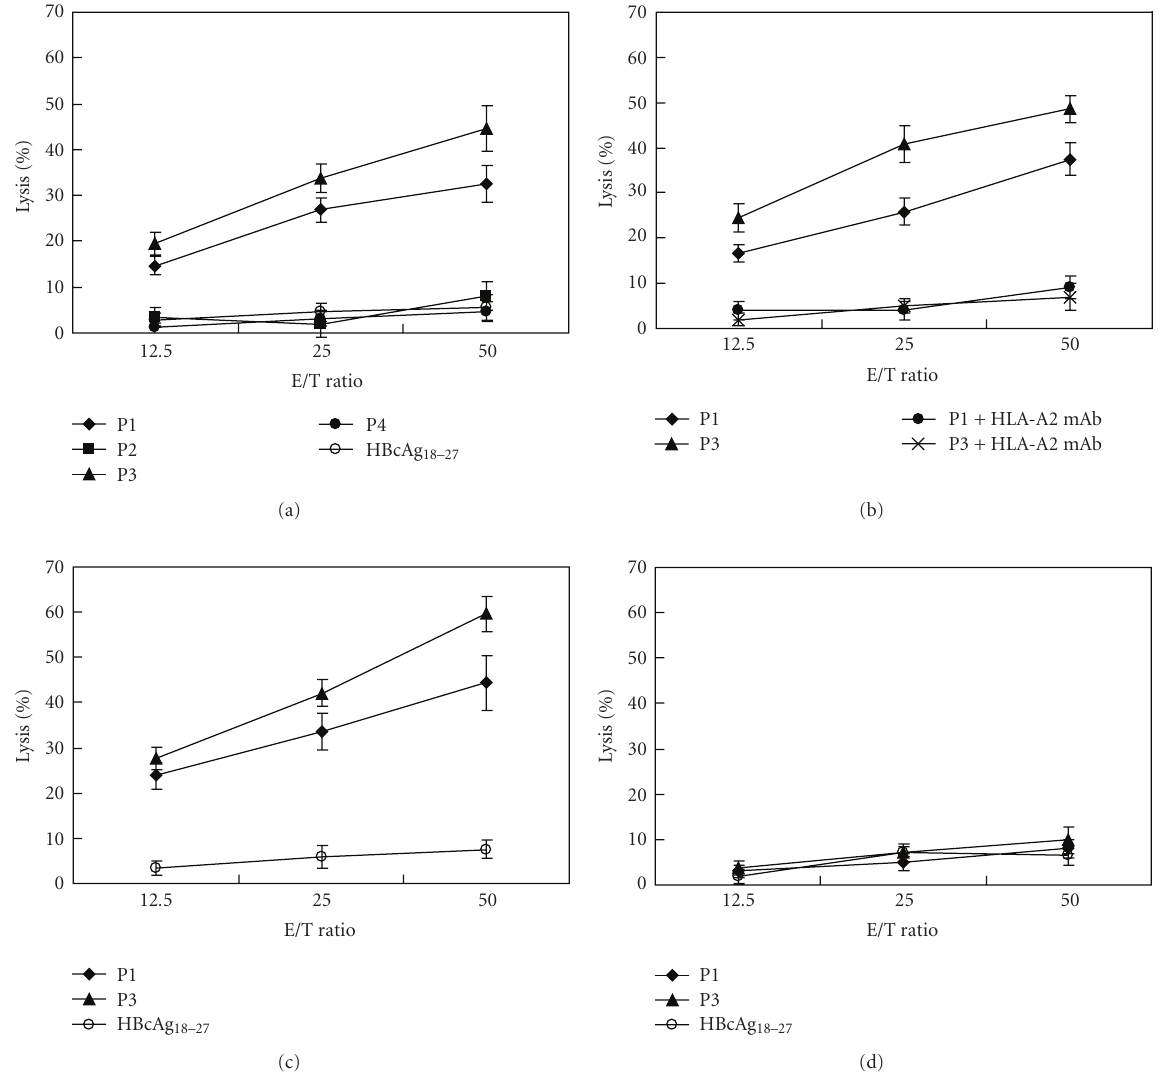
Figure 2: Induction of peptide-specific CTLs from human PBMCs. PBMCs from healthy HLA-A ∗ 0201 donors were first stimulated with peptide-pulsed autologous DCs and then restimulated with peptide-pulsed autologous PBMCs. After three to five days of the final stimulation, the stimulated PBMCs were used as e ff ector cells to detect their cytotoxic activity against tumor cells at the indicated E/T ratios in a cytotoxicity assay. The irrelevant peptide HBcAg 18–27 was taken as negative control. Each sample was measured in three replicates and the experiment was repeated three times. (a) P1, P2, P3, and P4-stimulated PBMCs mediated lysis of LB1751-MEL cells. (b) P1- and P3- stimulated PBMCs mediated lysis of LB1751-MEL cells (P1 and P3) and LB1751-MEL cells which surface HLA-A ∗ 0201 molecules were blocked with ant- HLA-A ∗ 0201 mAb (P1 + HLA-A2 mAb and P3 + HLA-A2 mAb). (c) P1- and P3-stimulated PBMCs mediated lysis of MCF-7A4 cells. (d) P1- and P3-stimulated PBMCs mediated lysis of MCF-7